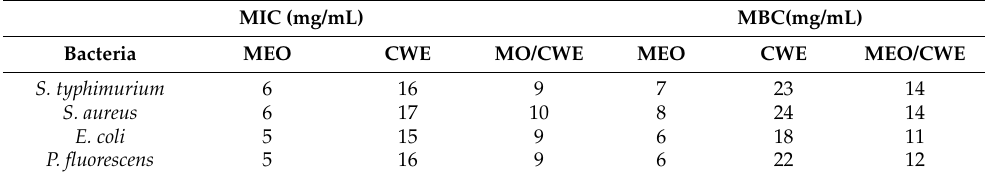
Table 4. The MIC and MBC values obtained for the MEO and CWE against different bacteria tested. MIC (mg/mL) MBC(mg/mL) Bacteria MEO CWE